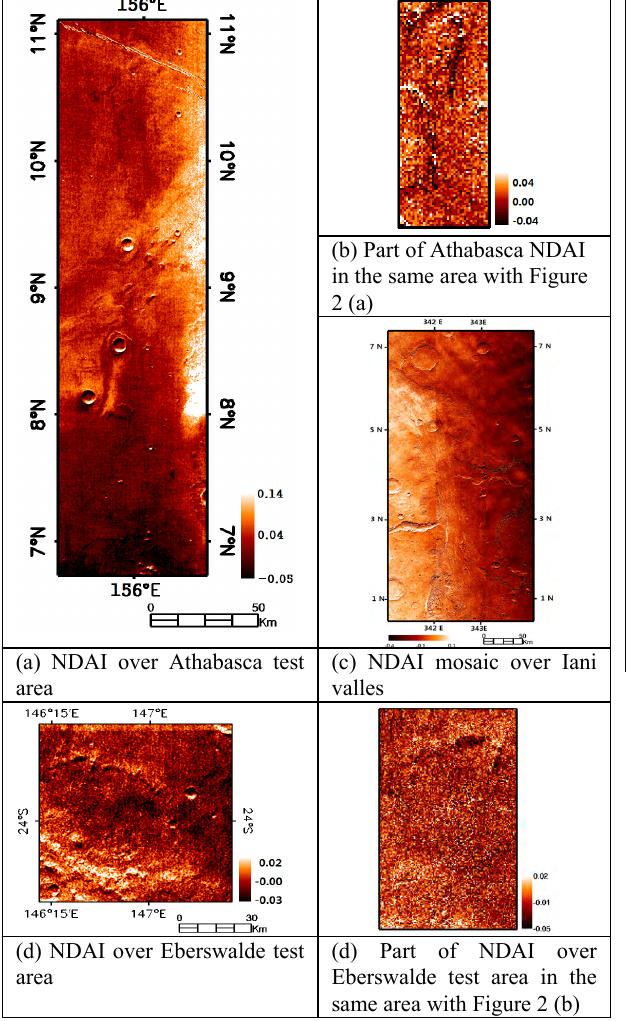
Figure 4. NDAI local roughness analysis by multi angle imaging